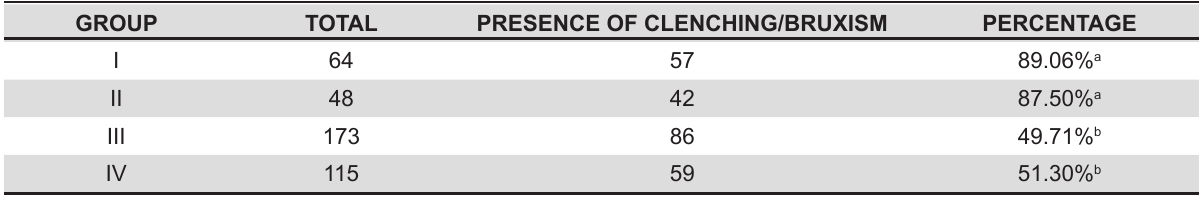
a indicates no between-groups differences (p>0.05) b indicates between-groups differences (p<0.05) Table 2- Chi-Square test (X2) and Odds Ratio (OR) of association between primary headache and clenching/bruxism parafunctional habits